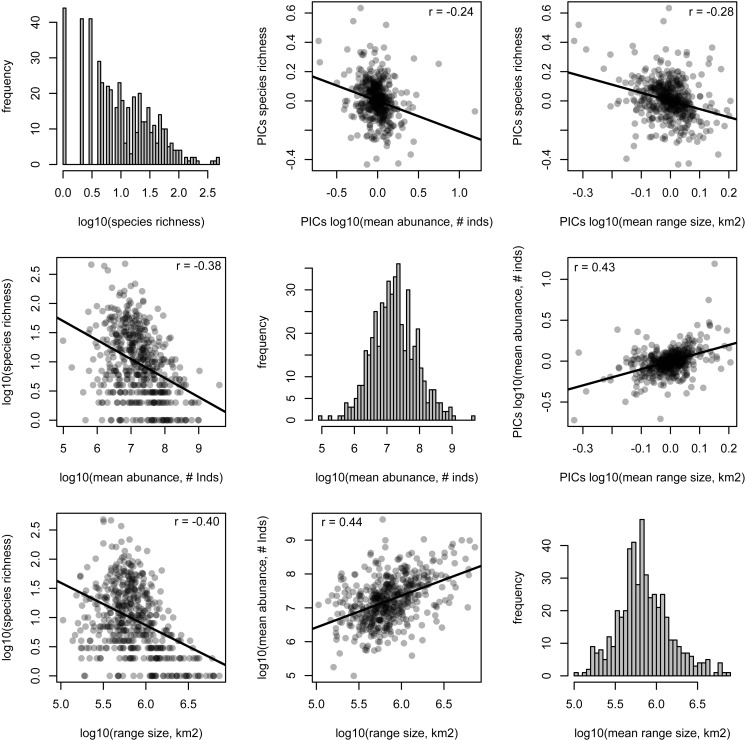
Relationships between species richness and mean range size and abundance for Amazonian tree genera.Histograms of each genus-level characteristic are given on the diagonal. Below the diagonal the raw relationships are shown along with the best-fit linear relationship and the Pearson correlation coefficient. Above the diagonal, the relationships of phylogenetically independent contrasts (PICs) are shown along with the best-fit linear relationship that is forced through the origin and the Pearson correlation coefficient.